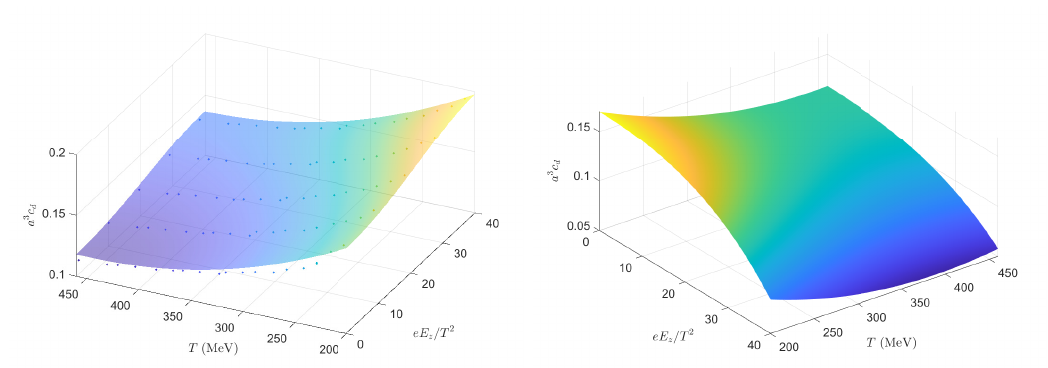
Figure 13 . Same as figure 11 but fitted using eq.